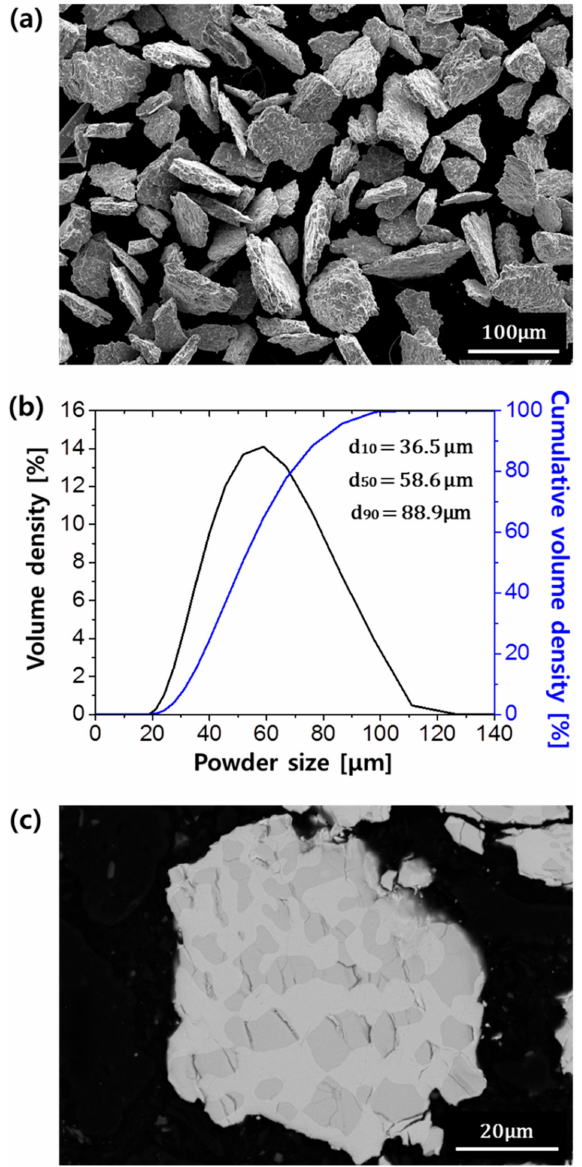
Figure 3. ( a ) The scanning electron microscope (SEM) image shows the morphology of the dehydrogenated powders and ( b ) their size distribution, and ( c ) the cross-sectional image shows the inner structure of the powder.